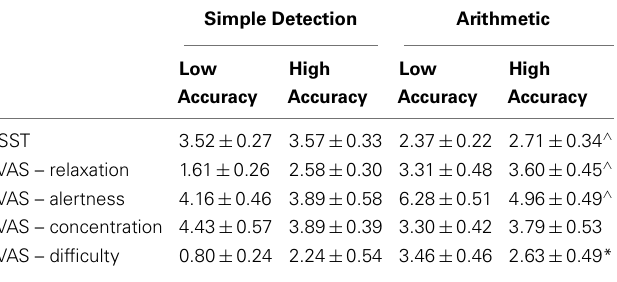
Table 3 | Mean ( ± SEM) subjective measures for the Stanford Sleepiness Scale (SSS), and measure on the visual analog scales (VAS) for relaxation, alertness, concentration and task